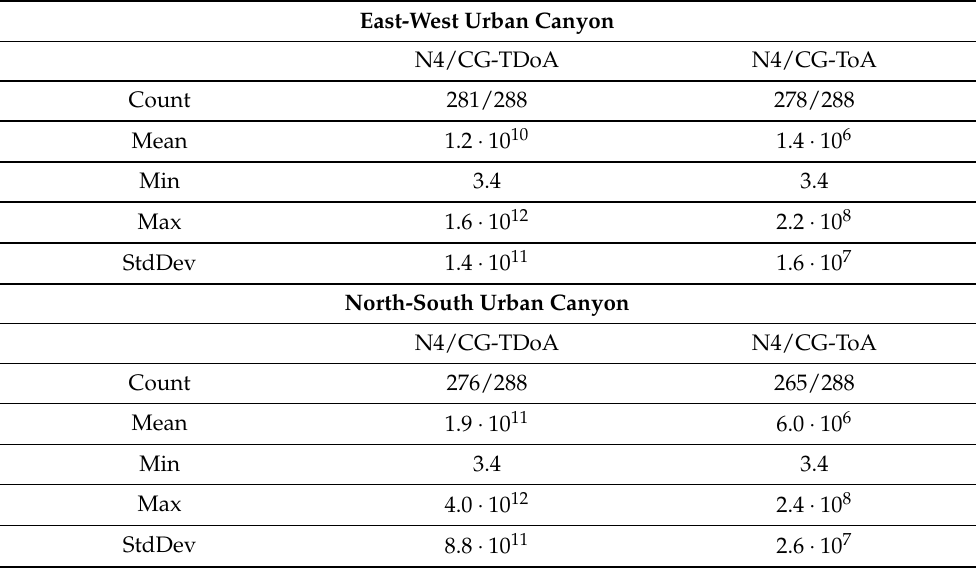
Table 8. Urban canyon scenarios: statistical analysis of PDOP for GNSS and four mirrored 5G stations (N4) in TDoA (CG-TDoA) and ToA (CG-ToA) processing.